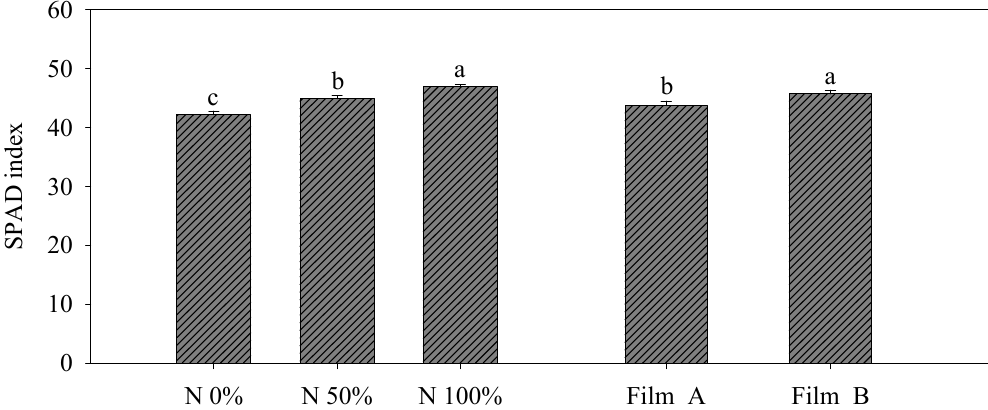
Figure 4. Effect of N fertilization (not fertilized = N0%; fertilized with 25 kg N ha − 1 = N50%; fertilized with 50 kg N ha − 1 = N100%) and plastic film (clear plastic film = Film A; light diffusion plastic film = Film B) on spinach SPAD (soil and plant development) index. Diverse letters on the bars indicate. Significant differences according to Duncan’s test ( p = 0.05). Vertical bars designate ± SE (standard error) of means.